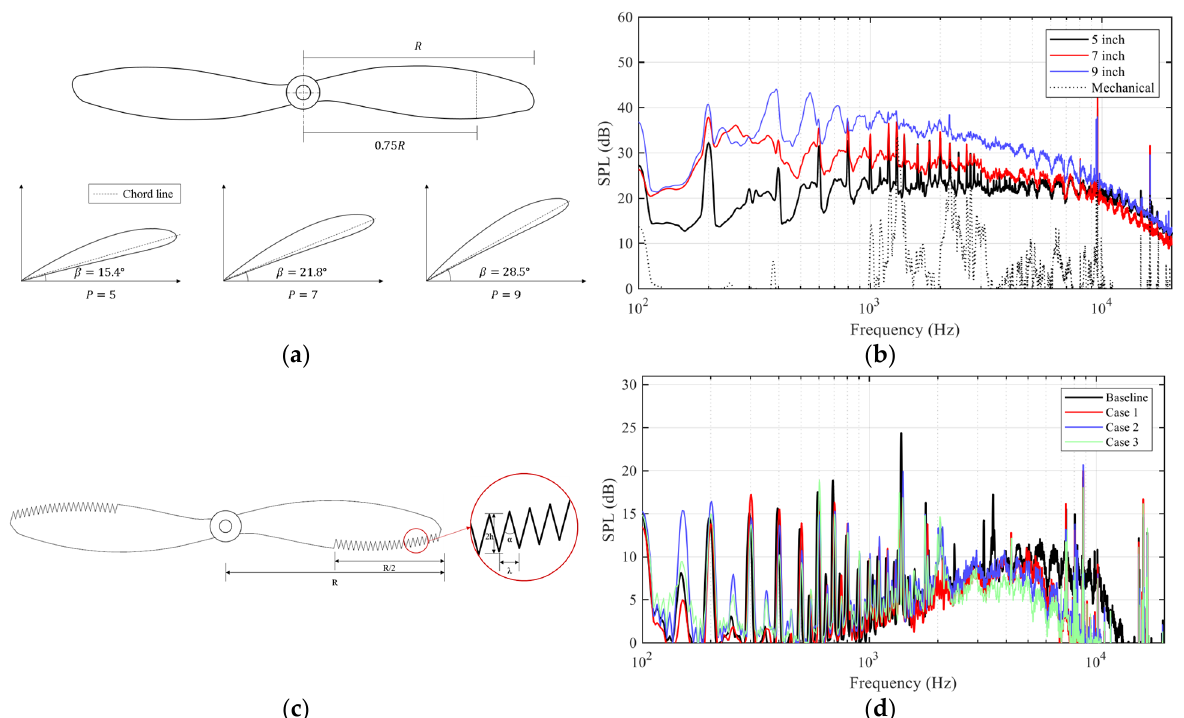
Figure 3. Effects of pitch angle and TE serrations as a passive noise control technique [17]. ( a ) Schematic of propeller with different pitch angles. ( b ) Spectra showing effects of pitch angles. ( c ) Schematic of propeller showing Trailing edge serrations. ( d ) Spectra showing effects of various serration depths and angles at 3000 rpm. Reprinted with permission from Azarpeyvand, M. (2018).